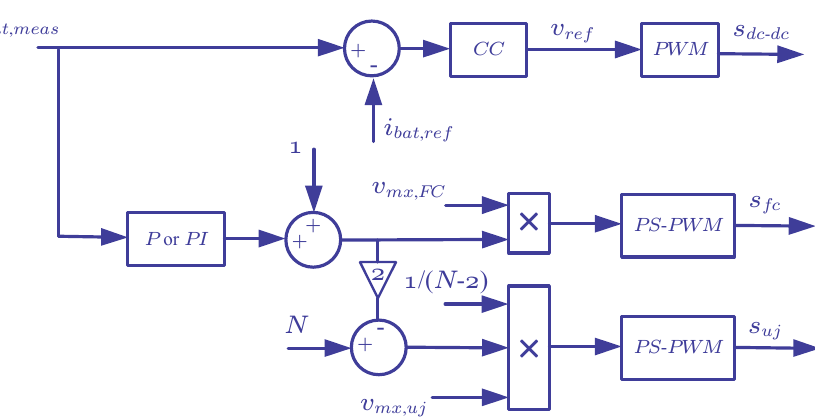
Figure 7. Energy control for the HMMC with embedded